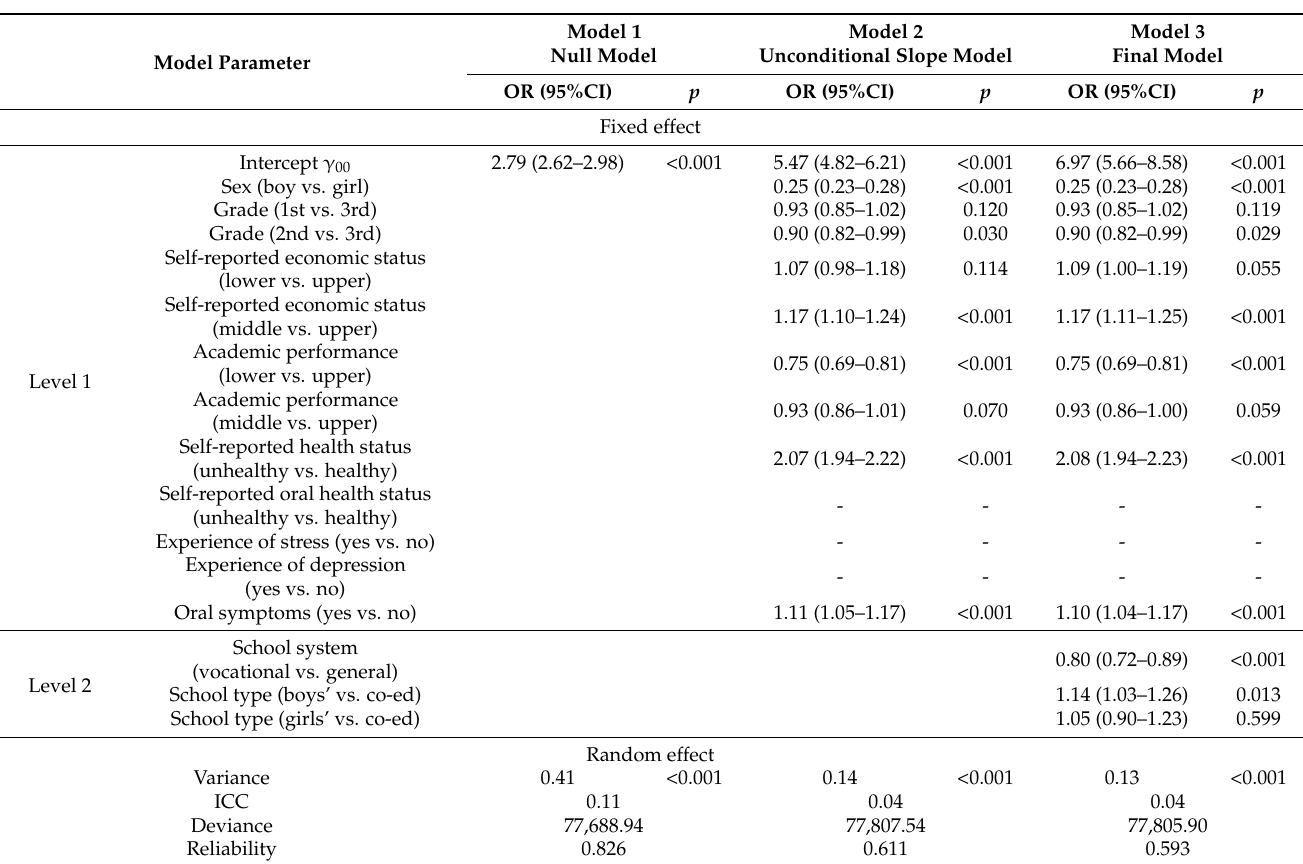
Table 6. Multilevel analysis of students’ high-intensity physical activity performance (two days a week or